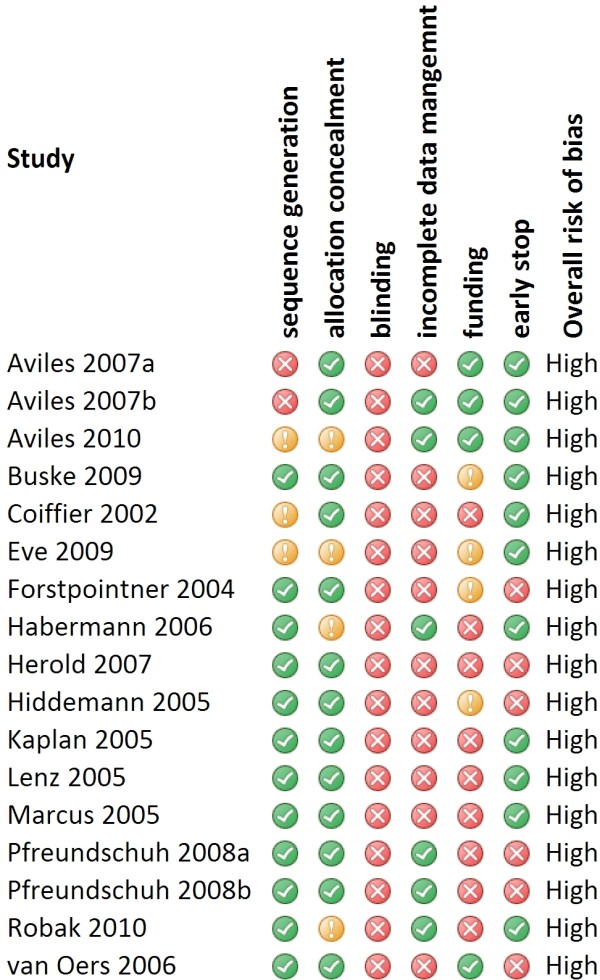
Within-study risk of bias. This figure shows the summary of within-study risk of bias. Green icons indicate methodological features adequately undertaken and reported, yellow icons indicate methodological features unclearly reported, red icons indicate methodological features inadequately undertaken.